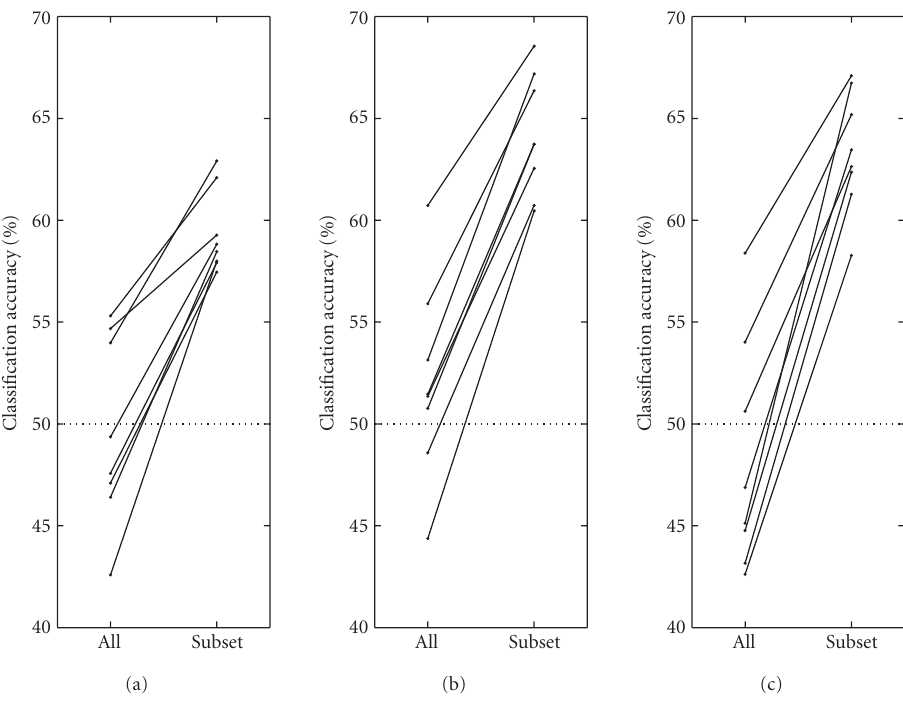
Figure 4: Feature subsets outperform the whole feature set across feature classes and subjects. “All” refers to the full set of all features, and “subset” refers to the feature subsets found by the GA. Each line connects the mean classification accuracies for both cases for a single subject for each of the (a) “original,” (b) “Infomax,” and (c) “MNF”